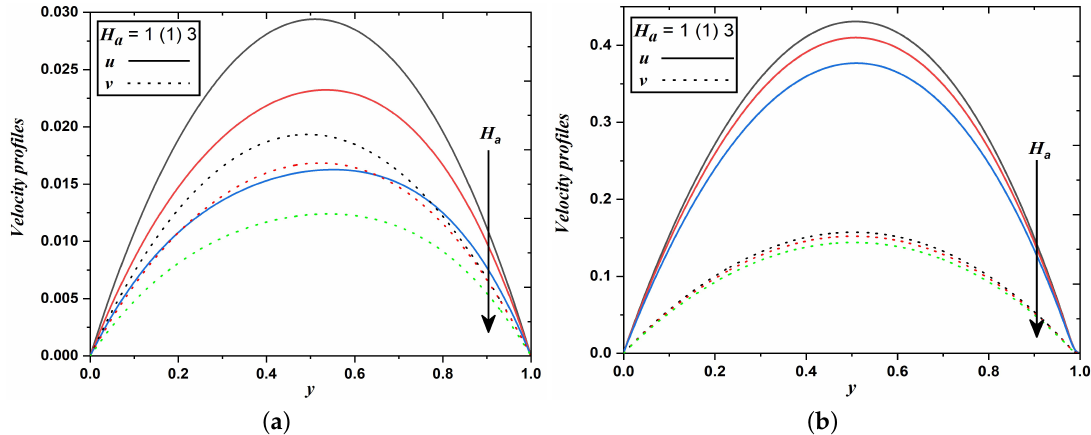
Figure 5. Velocity profiles when Hartmann number varies (Case 1 & 2).